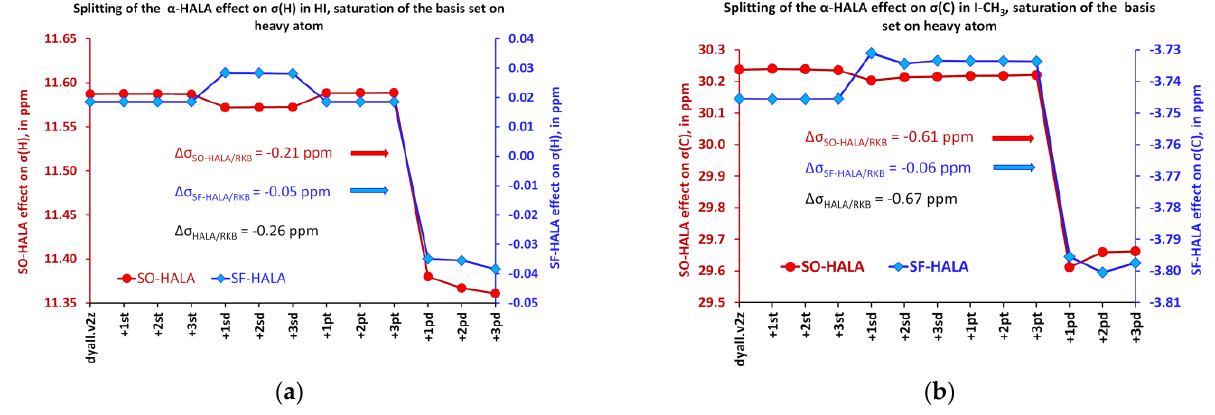
Figure 3. Splitting of the α -HALA effect into SO and SF contributions while saturating the heavy basis set in: ( a ) HI; ( b ) I-CH 3 .